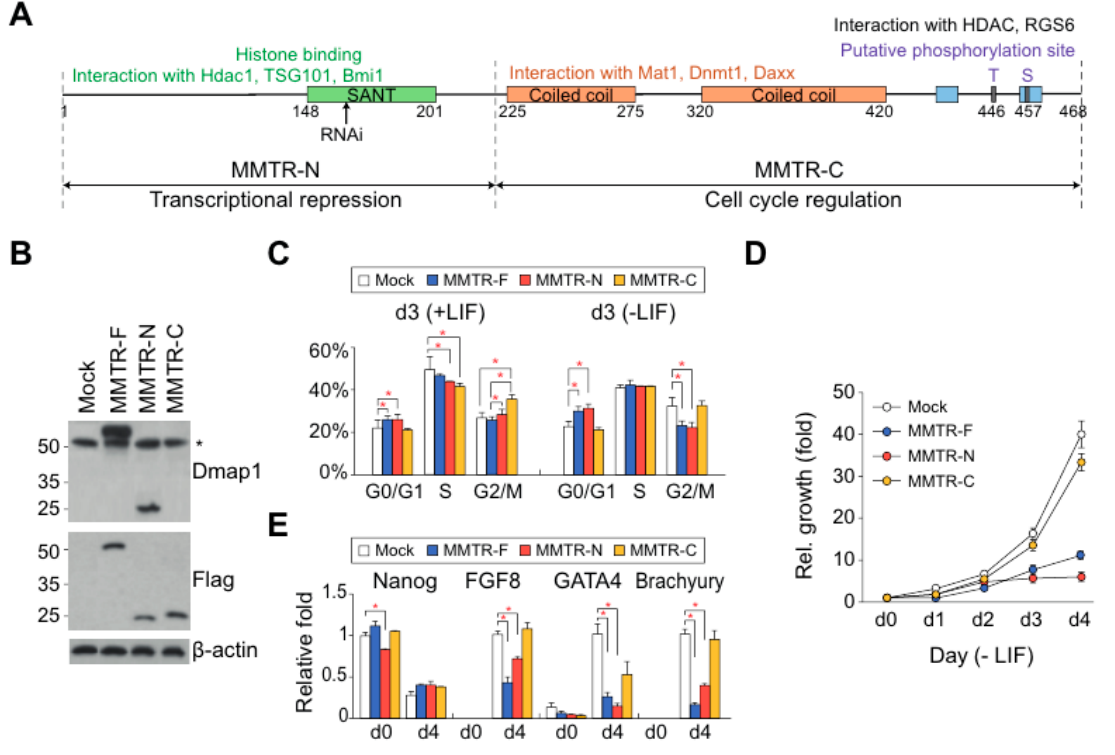
Figure 2. Establishment and characterization of MMTR-F, -N, and -C mESC lines. ( A ) Diagram of each MMTR mutant clone and ( B ) validation of their expressions by immunoblotting. Specific antibodies for immunoblots are shown at the right side of the photos, and the asterisk (*) denotes endogenous MMTR/Dmap1. ( C ) Cell cycle profile by flow cytometry. ( D ) Cell proliferation rates. ( E ) RT-qPCR of stemness and three germ layer specific markers. n = 2. * p < 0.05.